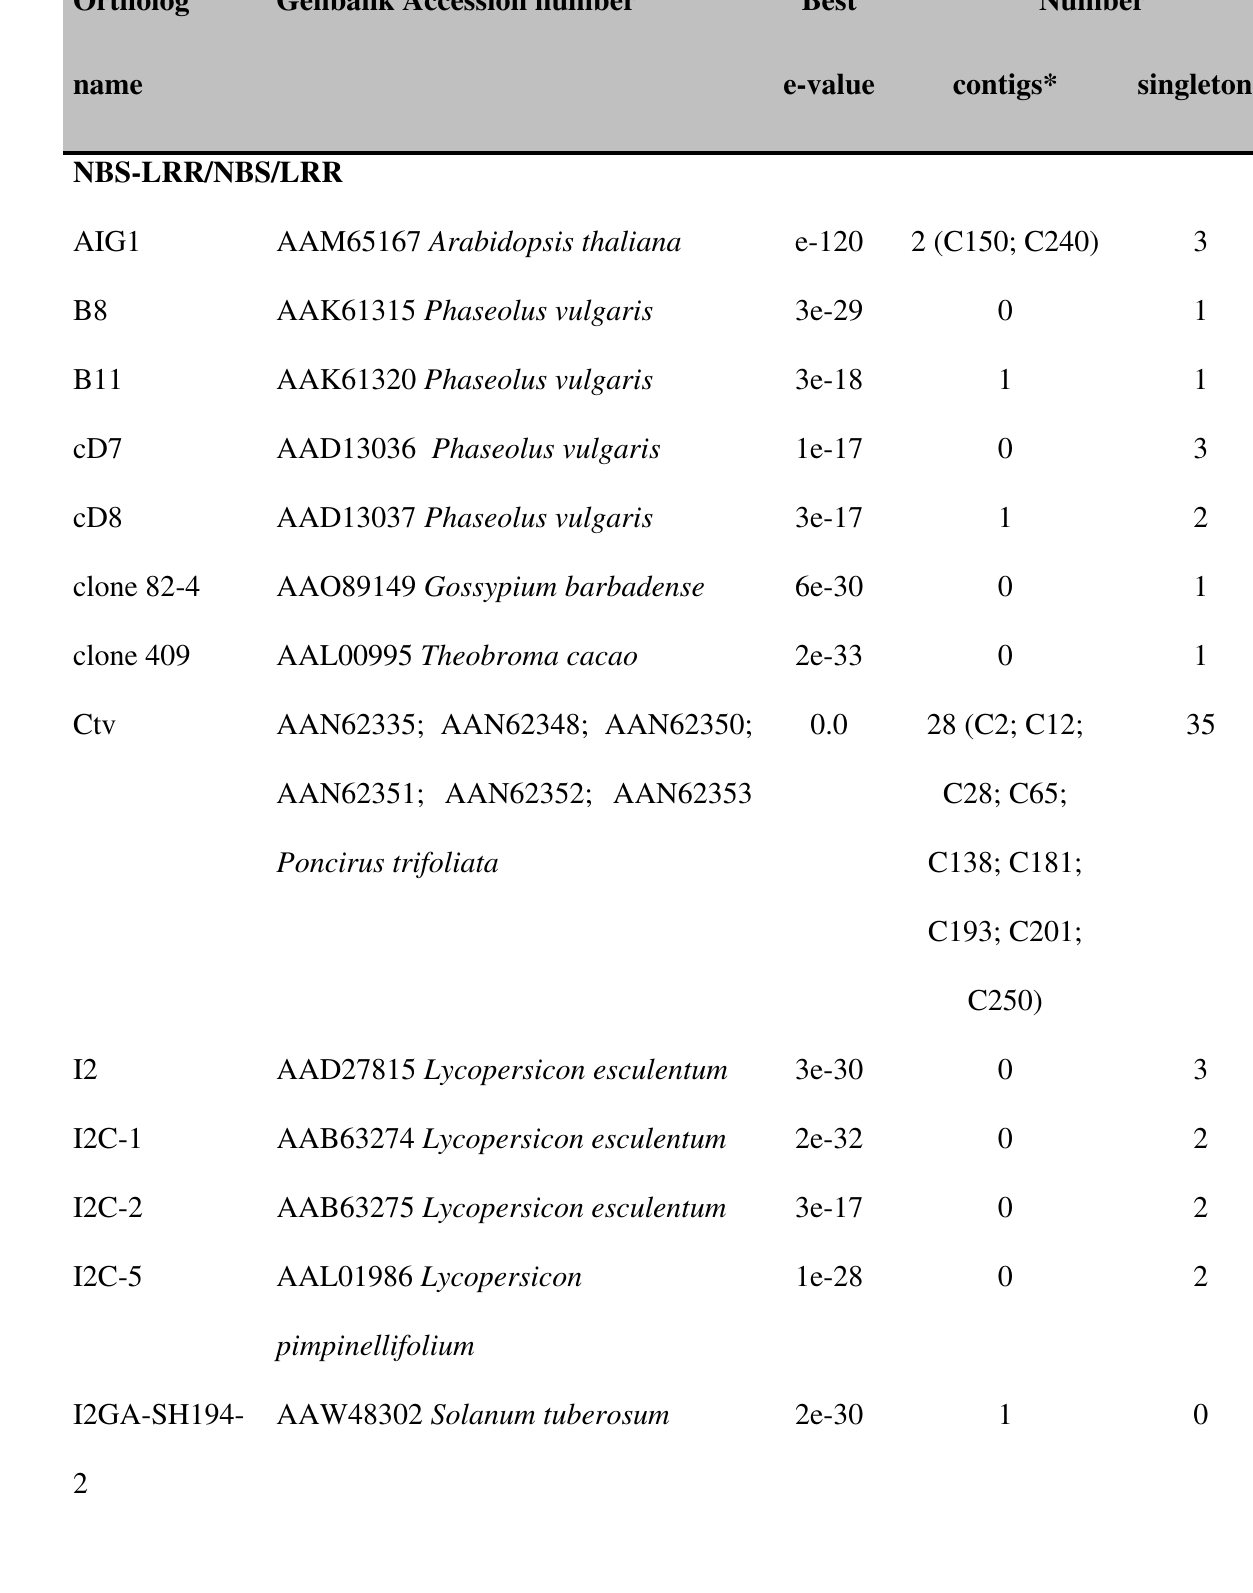
Table S1 - Number of contigs and singletons of the CitEST database, similar to know R